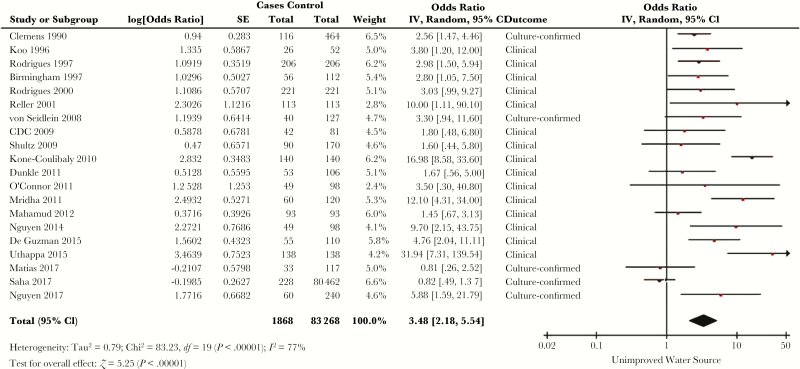
Forest plot of studies included in meta-analysis assessing whether exposure to an unimproved water source was associated with symptomatic cholera. The summary odds ratio was calculated using random effects models. Heterogeneity is described using the Cochran Q test and the I2 statistic. Abbreviations: CI, confidence interval; df, degrees of freedom; IV, inverse variance; SE, standard error.